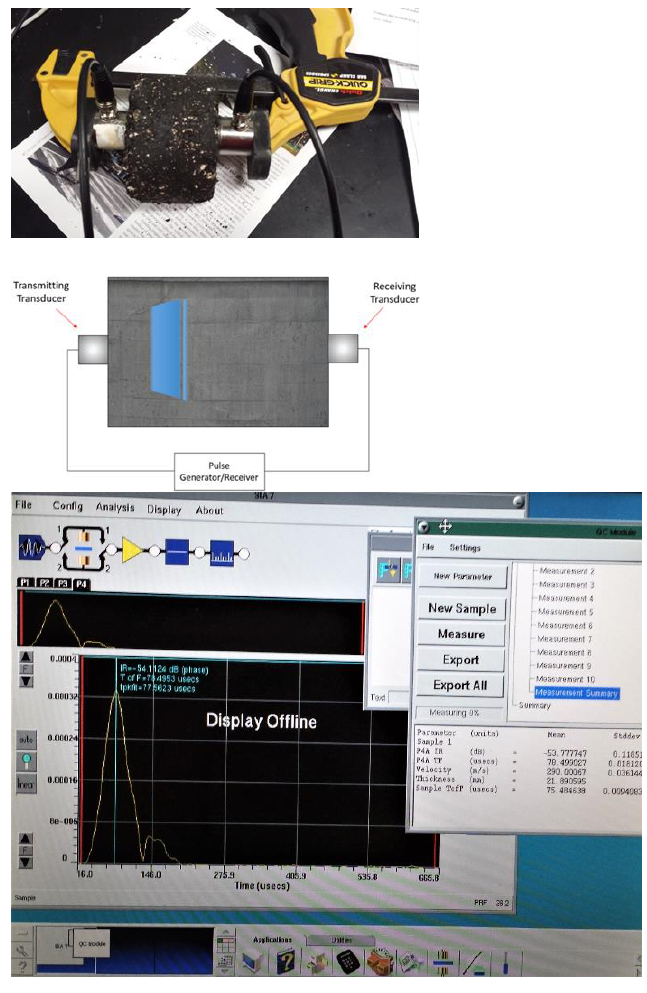
Figure 1. Ultrasound wave propagation on an asphalt sample.